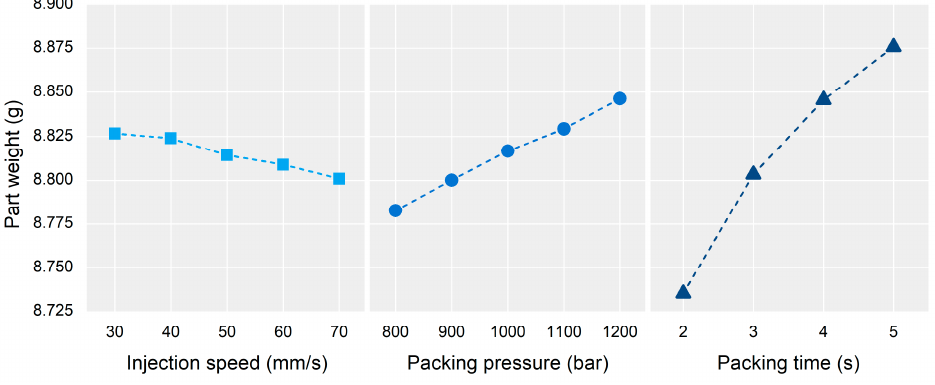
Figure 12. Contribution analysis results for the specific samples, ( a ) the highest ‐ weight sample, ( b ) the middle ‐ weight sample, and ( c ) the lowest ‐ weight sample.